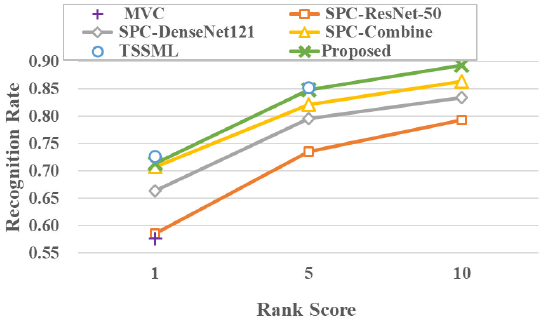
Figure 9. Performance comparison on the DukeMTMC-reID dataset. Table 7. Performance comparison on the Market-1501 dataset.